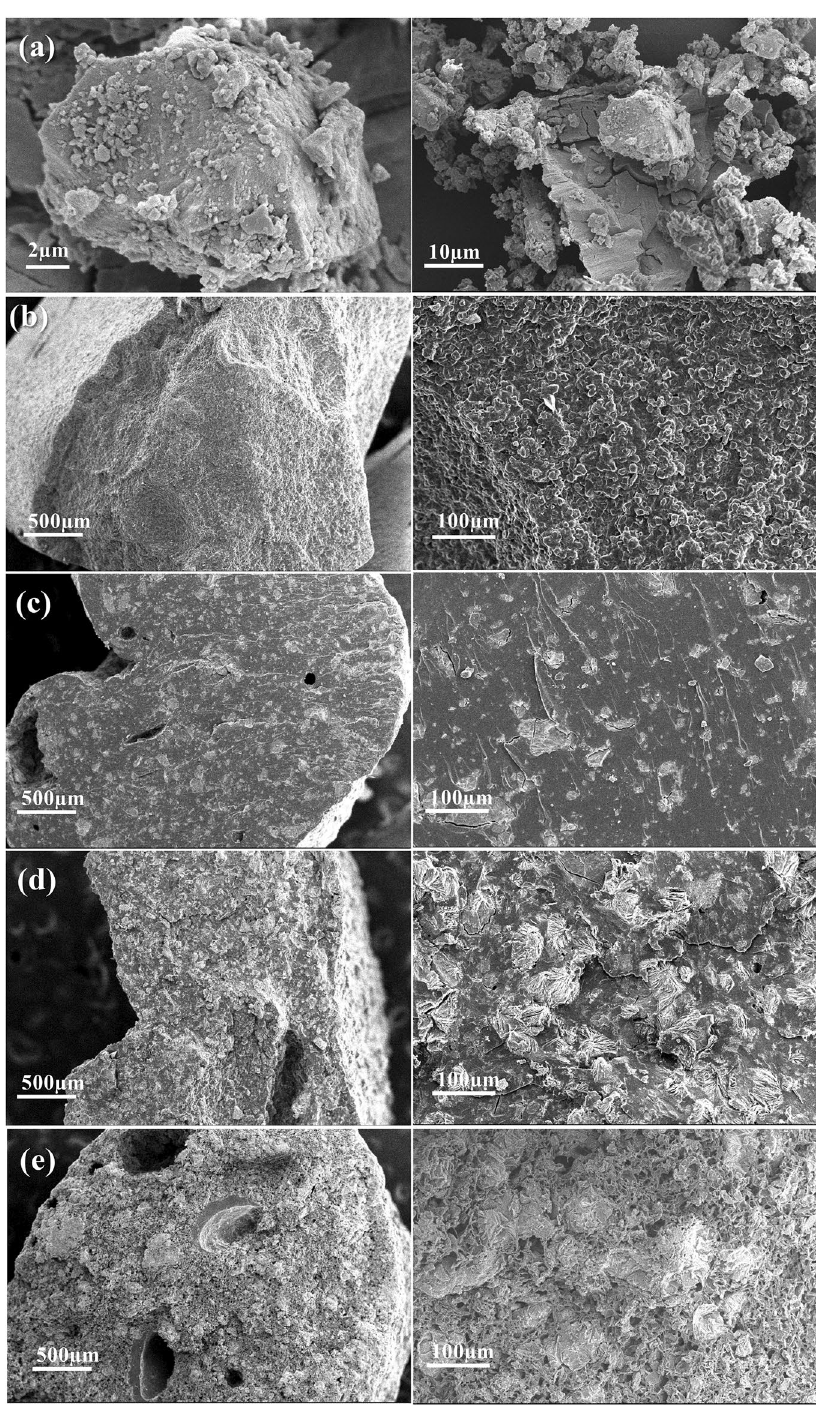
Figure 1. SEM images of ( a ) pure struvite, ( b ) TPS, and composites ( c ) 25 St-TPS, ( d ) 50 St-TPS, and ( e ) 75